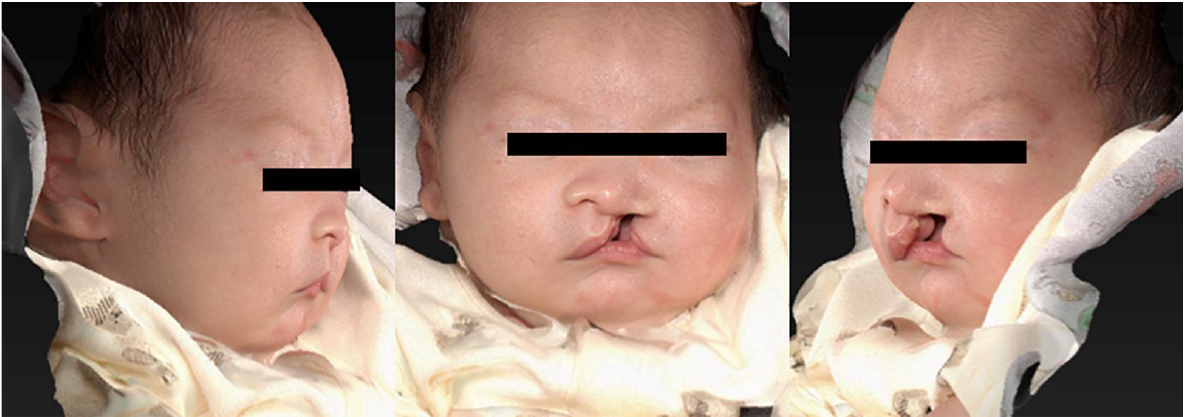
Figure 2. Three-dimensional imaging of one infant with the 3D analyzer. A digital dental caliper (Mitutoyo Corp., Kanagawa, Japan) was used to measure the maximum protrusion of the alveolar bone on the healthy and affected sides to measure cleft jaw width on the model (Figure